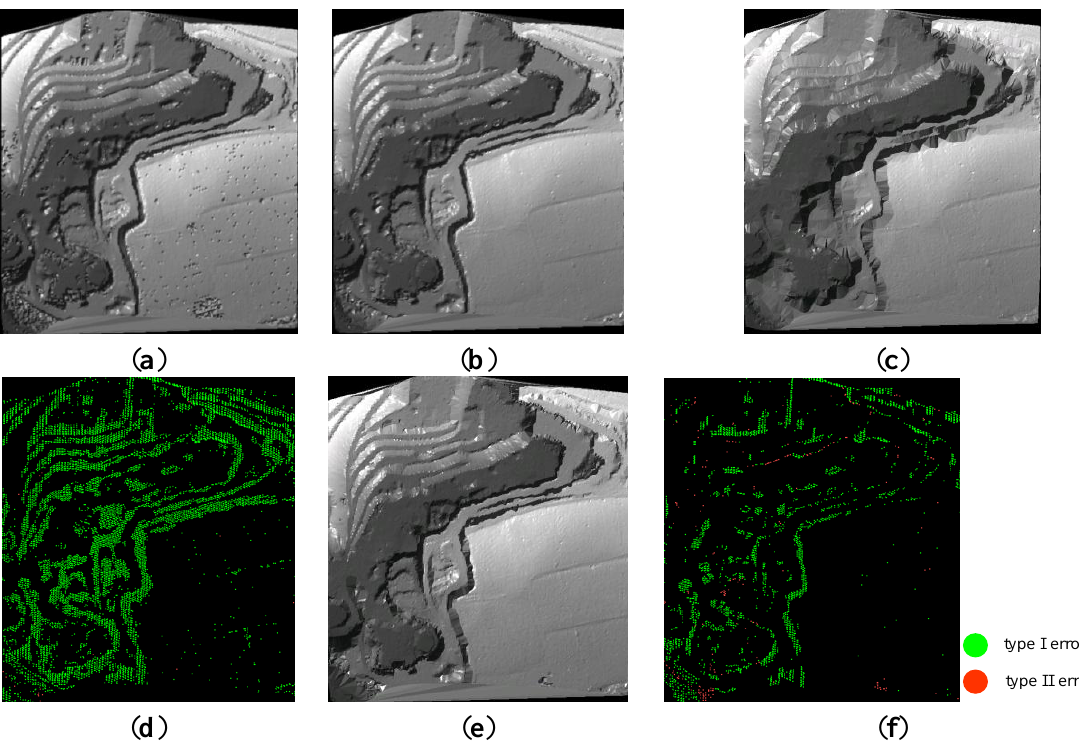
Figure 10. Filtering and results of reference data of Sample 53: ( a ) The DSM; ( b ) The reference DEM; ( c ) The DEM generated from the result of the PTD method; ( d ) The type I errors, type II errors of the PTD method; ( e ) The DEM generated from the result of the SBF method; ( f ) The type I errors, type II errors of the SBF method. Note that both of the DSM and the DEM are TIN-based.